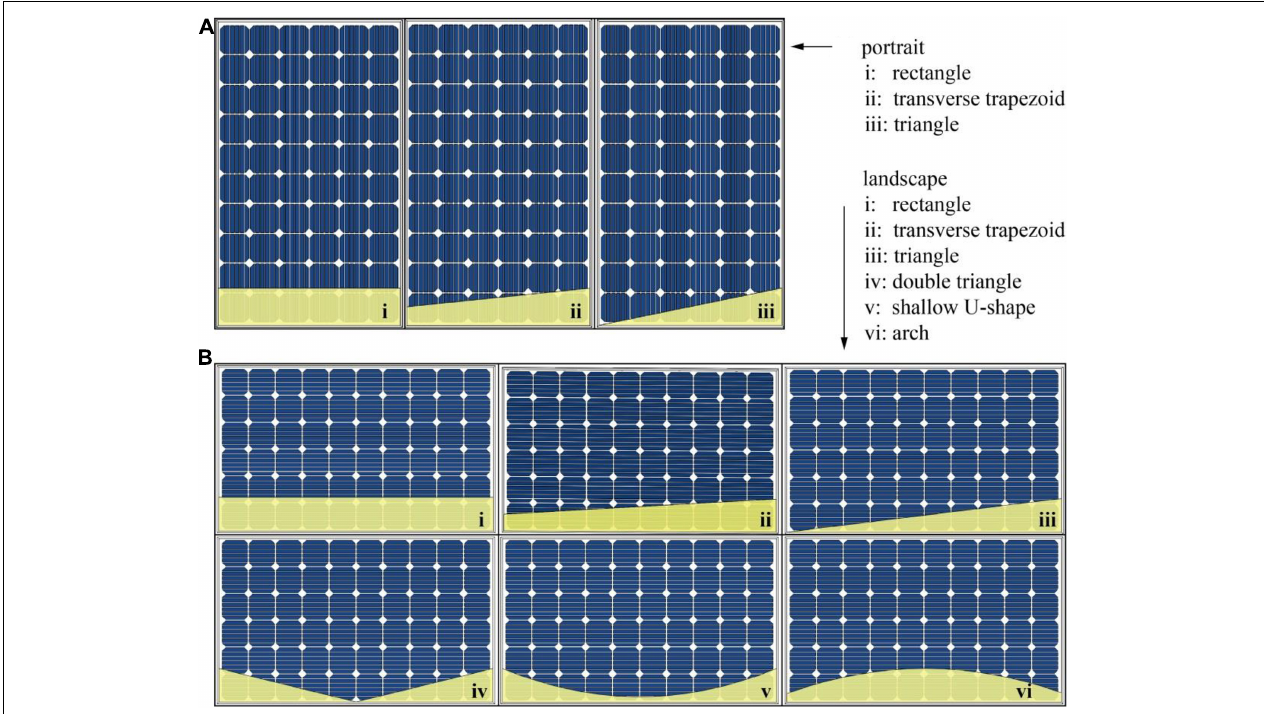
FIGURE 3 | Schematic showing the shapes of soiling bands: (A) portrait and (B) landscape